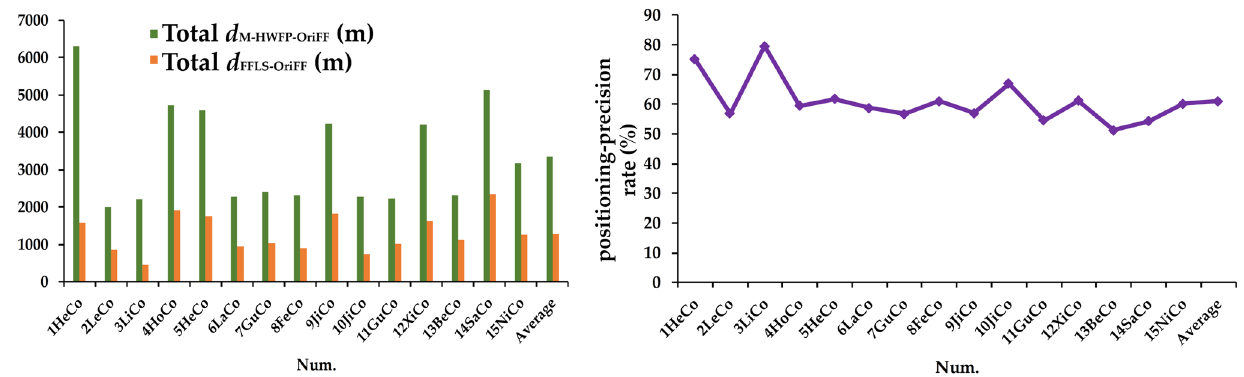
Figure 7. Positioning-accuracy comparison of M-HWFP to OriFF and FFLS to OriFF.